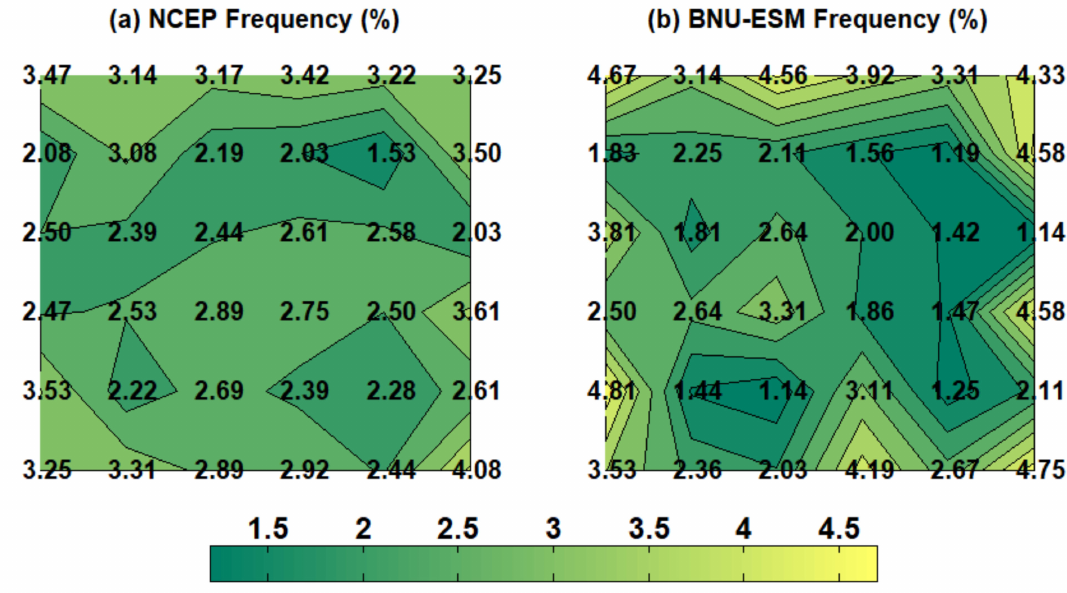
Figure 4. Weather pattern frequencies (%) for ( a ) NCEP and ( b ) BNU-ESM in